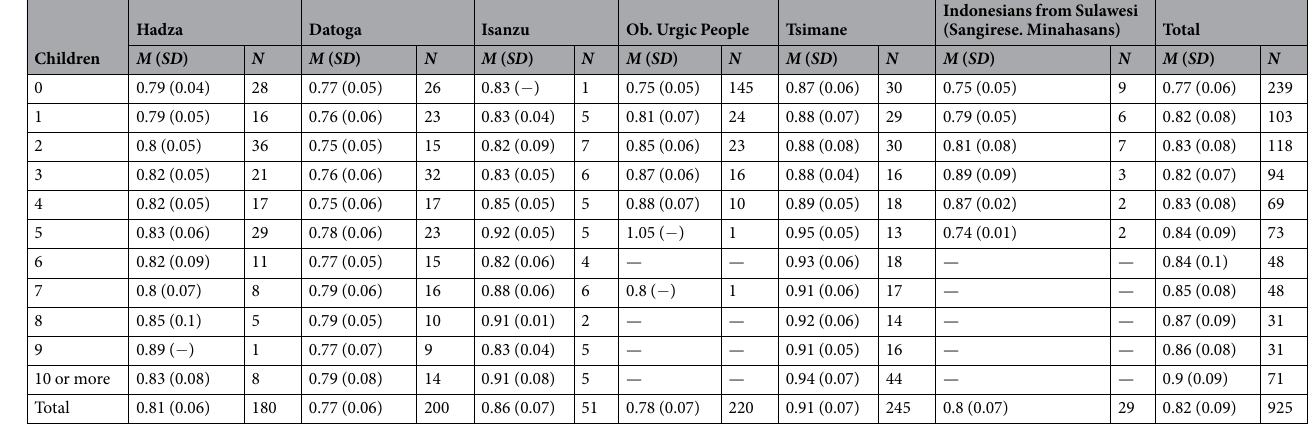
Table 2. The WHRs of women with different number of children across ethnicities.